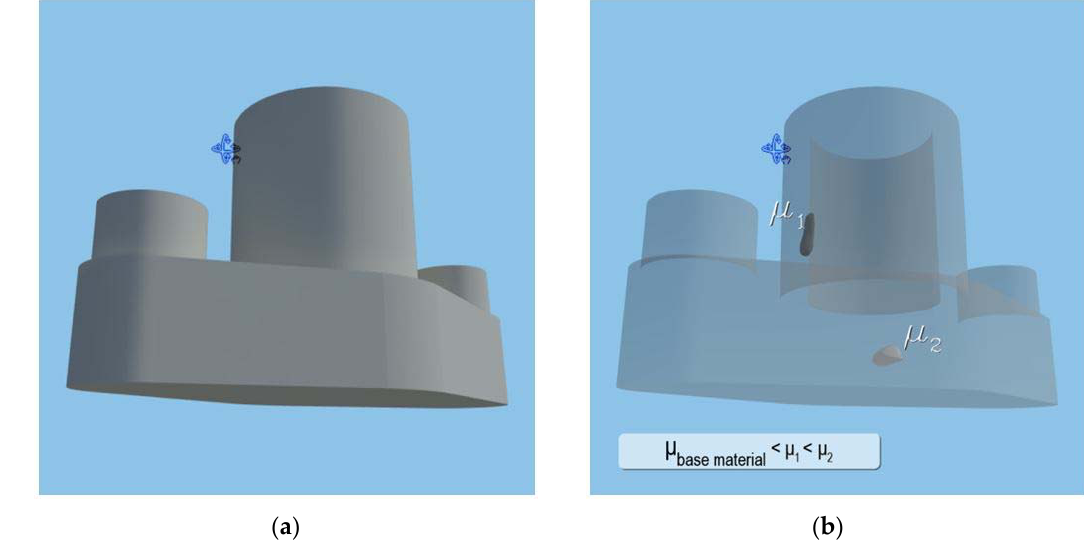
Figure 5. IVP to allow students to freely explore the parts and their internal defects: ( a ) opaque view; ( b ) translucid view, where inner inclusions are shown.